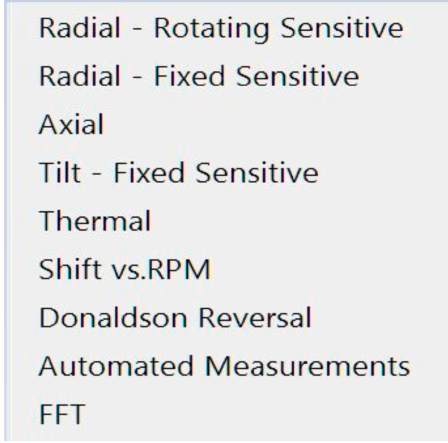
Figure 15. Program menu with available tests.